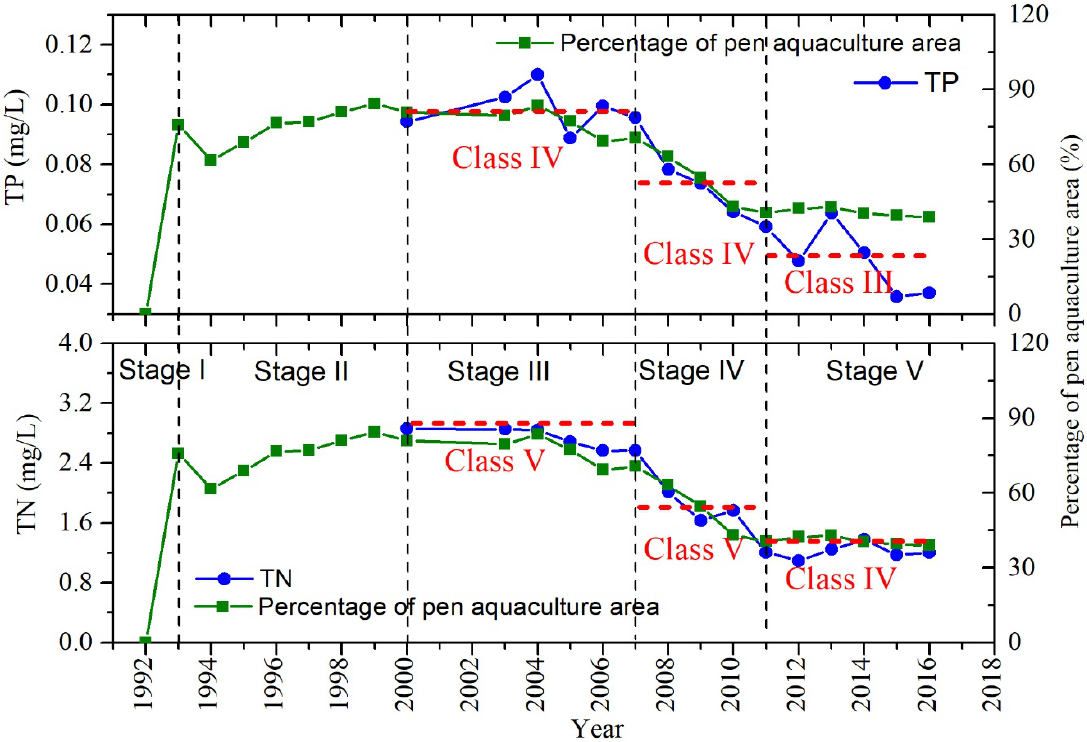
Figure 9. Changes in TN, TP and the percentages of pen area in the Central and Eastern Lakes. Due to the lack of WQ data in 2001 and 2002, pen aquaculture data in the two years were not shown in this figure.